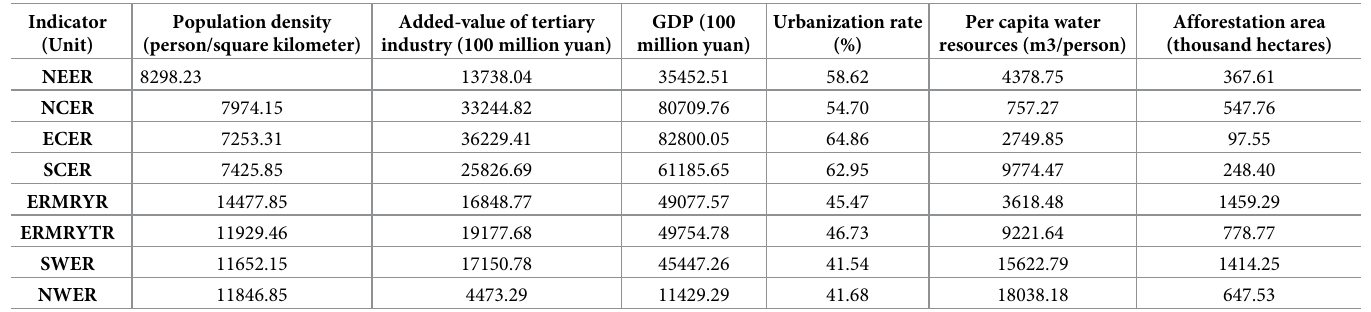
Added-value of tertiary industry (100 million yuan)